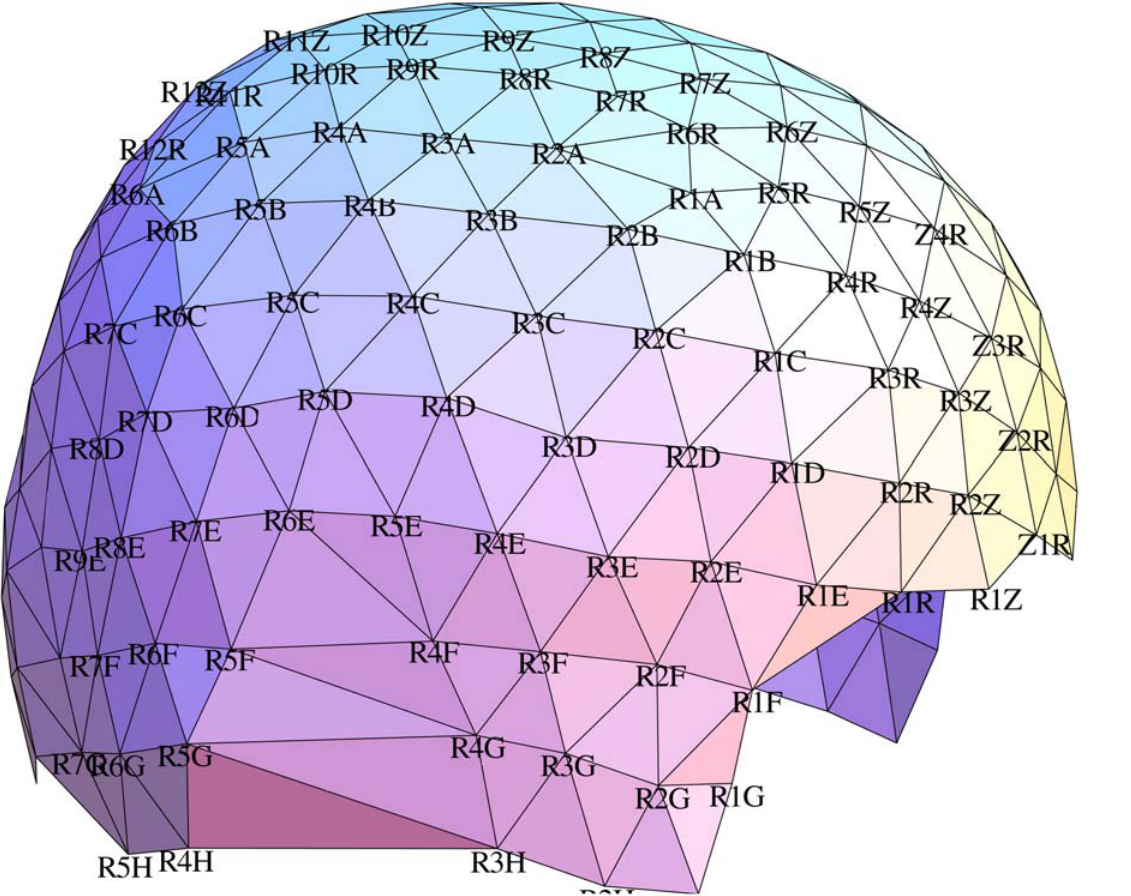
Fig 2. The digitized electrode positions of the EEG cap for one volunteer. The view direction is from the right